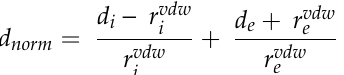
distance given in